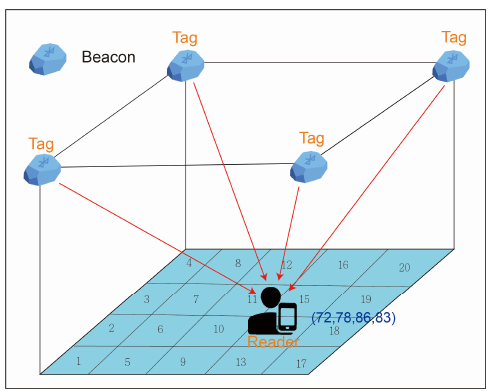
5 Figure 4. Location